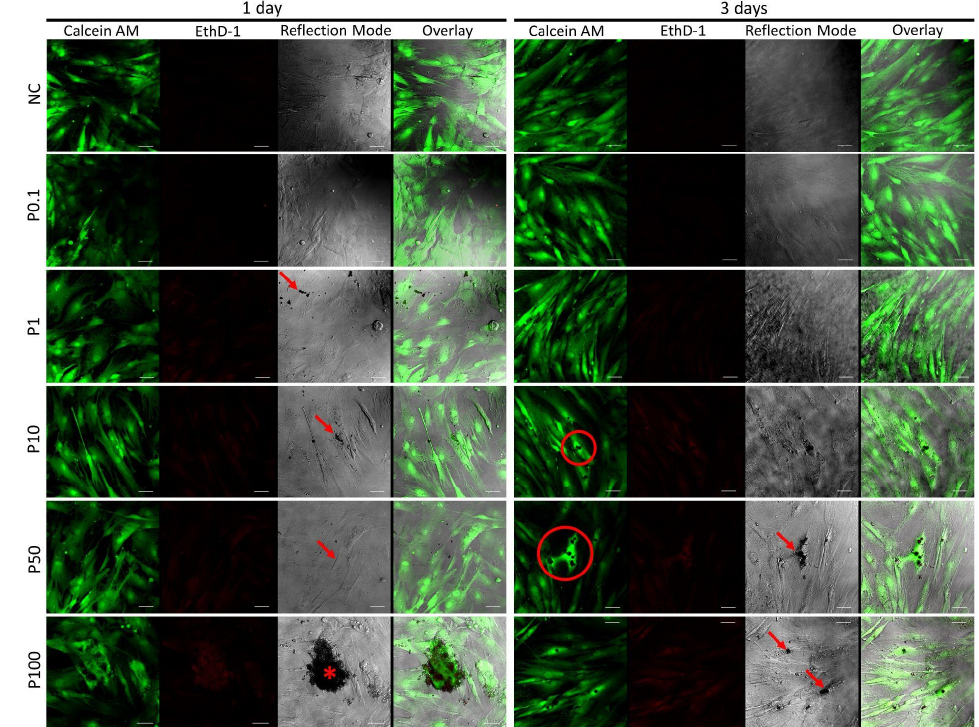
Figure 9. Confocal microscopy images of hMSCs cultured for 1 and 3 days in DMEM containing PLGA microspheres at concentrations of 0.1, 1, 10, 50, and 100 µg/mL identified as P0.1, P1, P10, P50, P100, respectively; the observation depicts live/dead cells (green and red, respectively), and small/large microsphere aggregates (arrows and asterisks, respectively). NC: negative control; bars 50 µm.